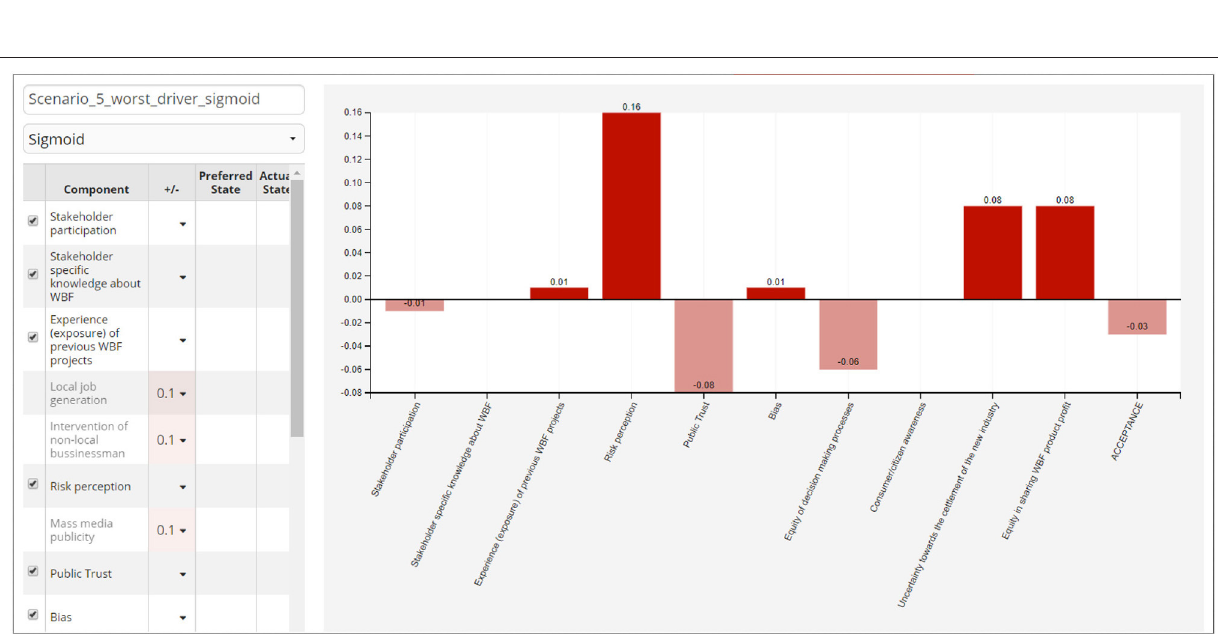
FIGURE 7 | The effect of the driver concepts in the Social_FCM for the worst case scenario compared to the steady state.